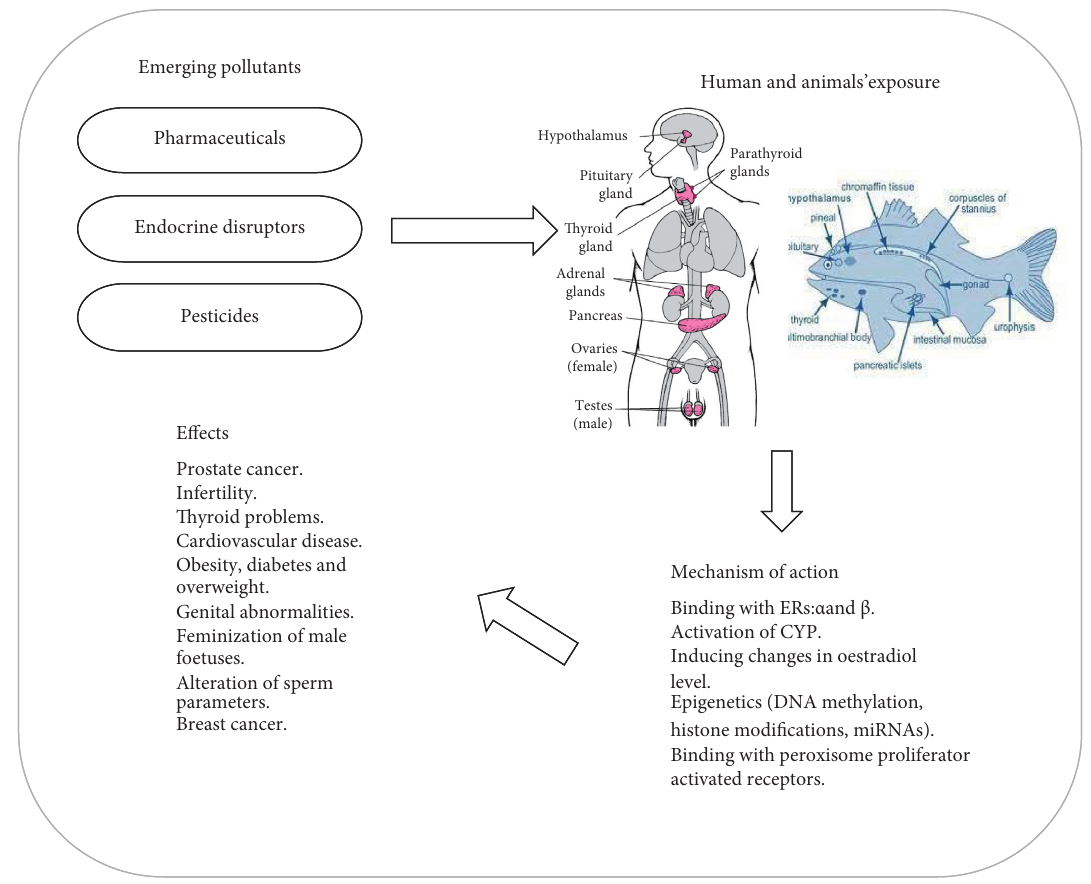
Figure 3: Schematic representation of emerging pollutant exposures, mode of action, and their health effects (based on [25, 68, 69]). Abbreviations: ERs, estrogen receptors; CYP, cytochrome P450 genes; and DNA, deoxyribonucleic